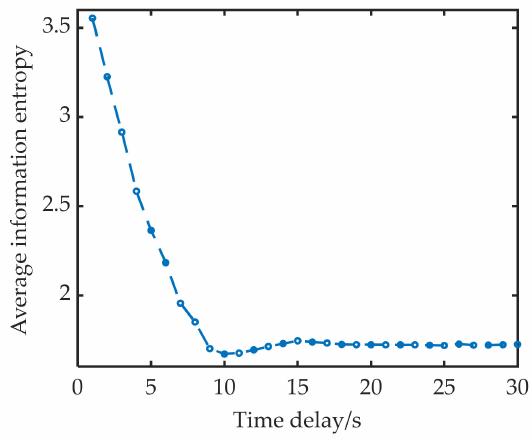
Figure 2. Average information entropy under different delay